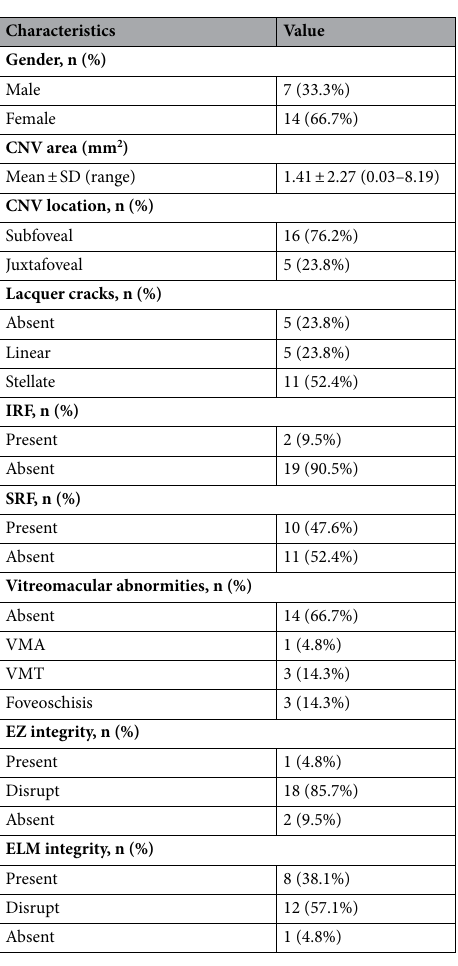
Table 2. Baseline characteristics of mCNV eyes in patients over 50 years old receiving Conbercept treatment. BCVA best-corrected visual acuity, CNV choroidal Neovascularization, IRF intraretinal fluid, SRF subretinal fluid, SFCT subfoveal choroidal thickness, VMA vitreomacular adhesion, VMT vitreomacular traction, EZ ellipsoid zone, ELM external limiting membrane, logMAR logarithm of the minimum angle of resolution, SD standard